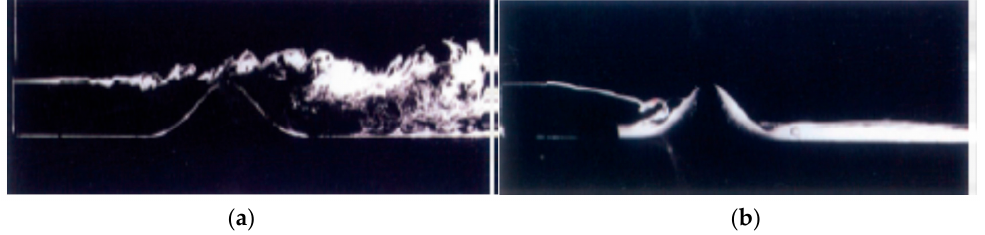
Figure 13. Images of gas dispersion around a hill in a thermally stratified wind tunnel (flow is from left to right). ( a ) Neutral stability; ( b ) Stable stability.